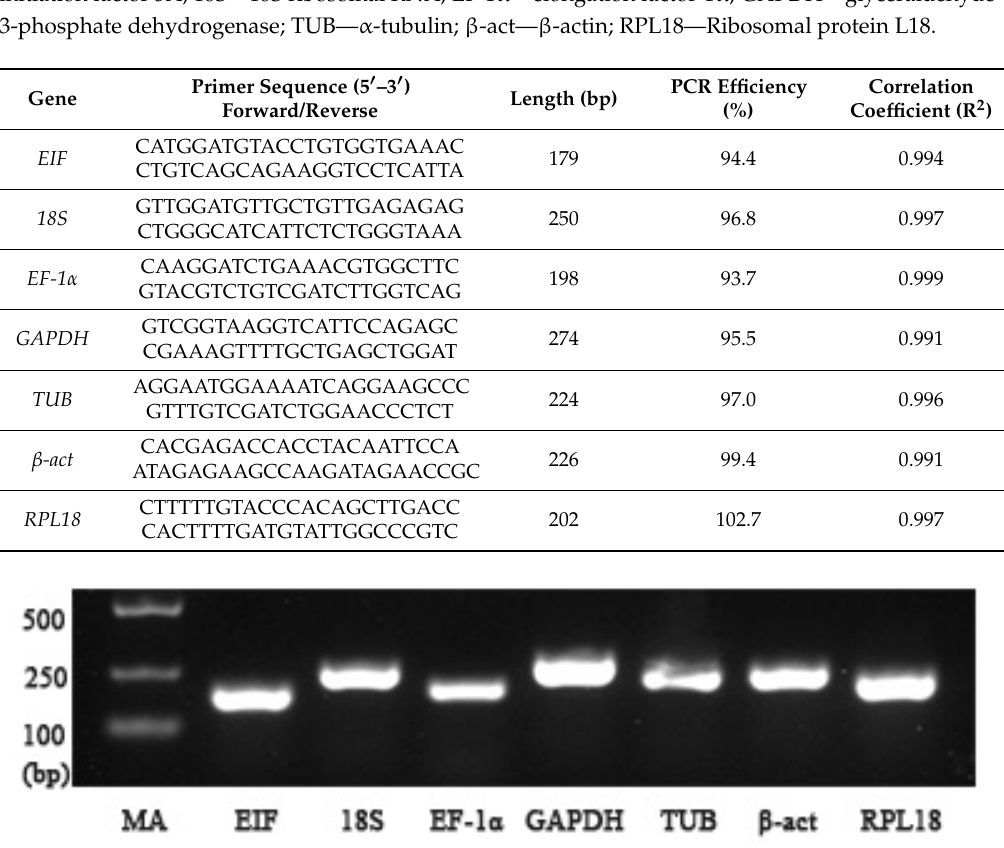
Primer pairs for qPCR of candidate reference genes.